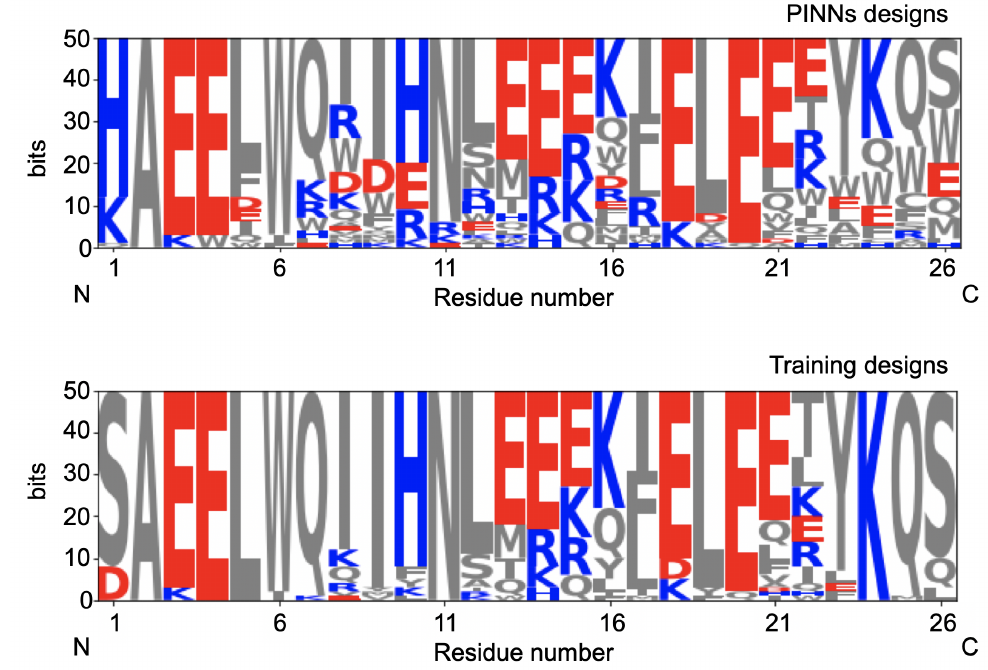
Figure 5. Design sequence logos of the 950 designs from the training set ( bottom ) and the PINNs- generated designs ( top ). Blue, red and grey colors indicate that the residues are positively charged, negatively charges or uncharged, respectively. It is evident that the PINNs designs are more diverse compared to the initial designs from the training set. Since the problem is highly non-convex, this allows us to generate many different sequences with different starting